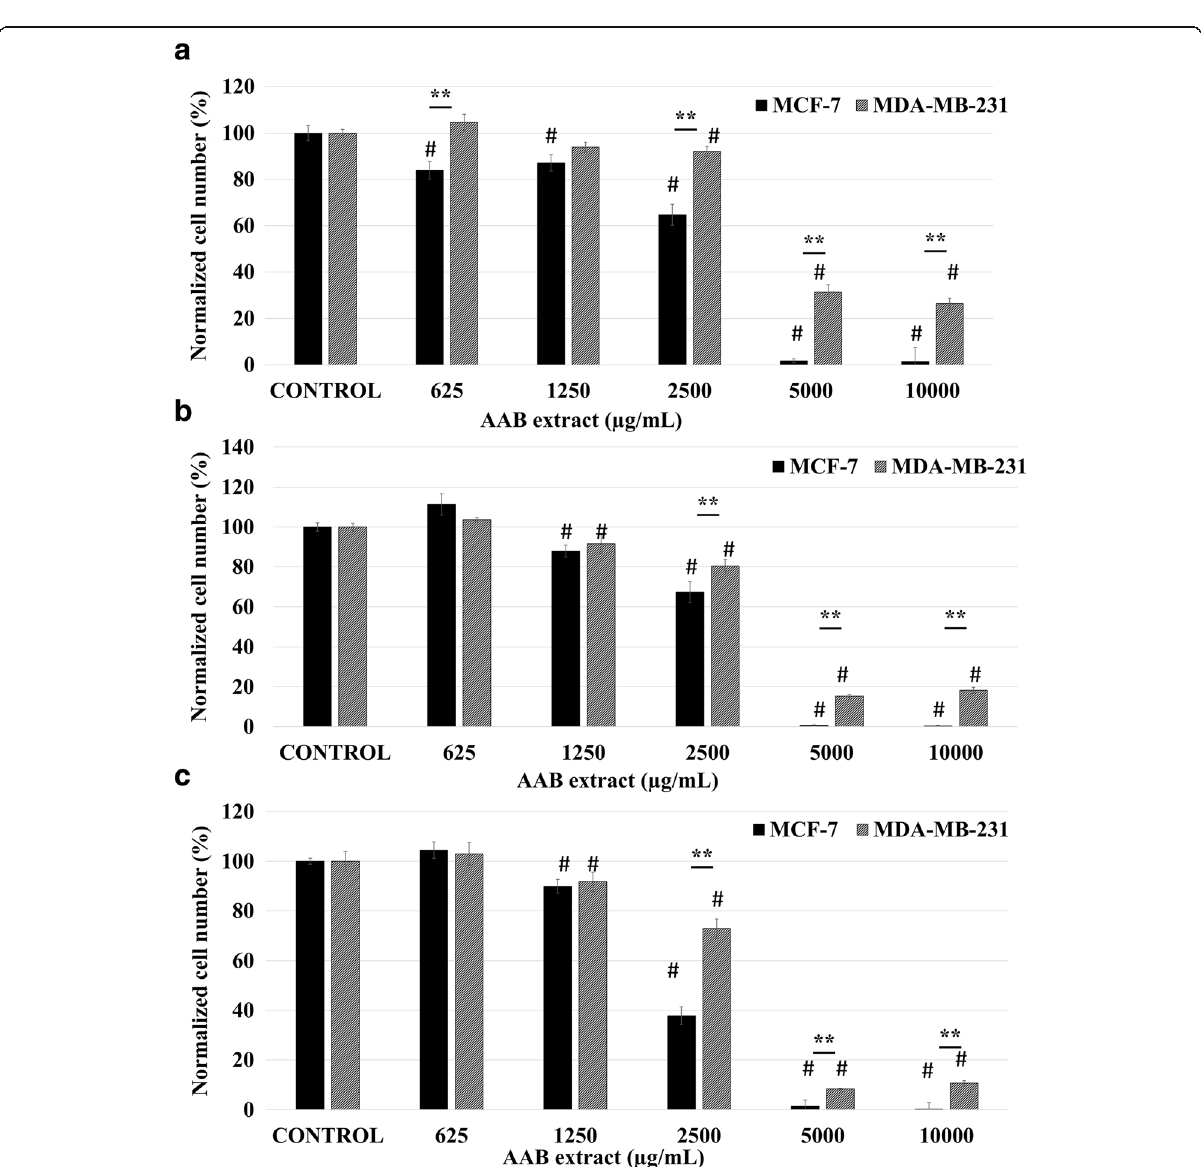
Fig. 1 AAB extract causes significant anti-proliferative effect on MCF-7 and MDA-MB-231 cells. Concentration-effect curves of AAB extract treatment 625 – 10,000 μ g/mL for 24 h ( a ), 48 h ( b ), and 72 h ( c ) in MCF-7 and MDA-MB-231 cells. Normalized cell number was calculated by using measurements from six independent MTT assays. Data is represented as mean±S.E.M. Statistical significance: #, p <0.05 vs control according to ANOVA followed by Newman-Keuls post hoc analysis. *, p <0.05 and **, p <0.01 MCF-7 vs MDA-MB-231 according to Student ’ s t-